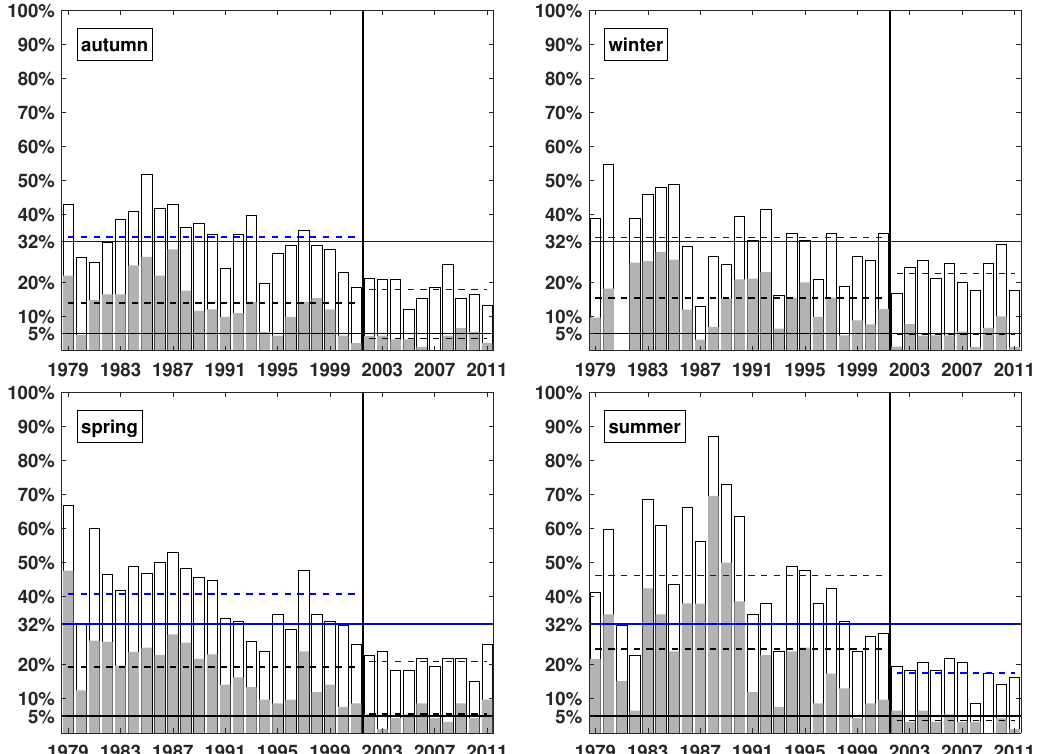
Figure 12. As Figure 11, but for autumn, winter, spring and summer. Limitations of the cross-validation procedure are particularly evident for the spring and summer seasons (see the larger gap between the dashed and the solid lines in the true evaluation period), and for the 95% confidence interval 2SE (because the gap between the black dashed and solid lines is larger than the gap between the blue dashed and solid